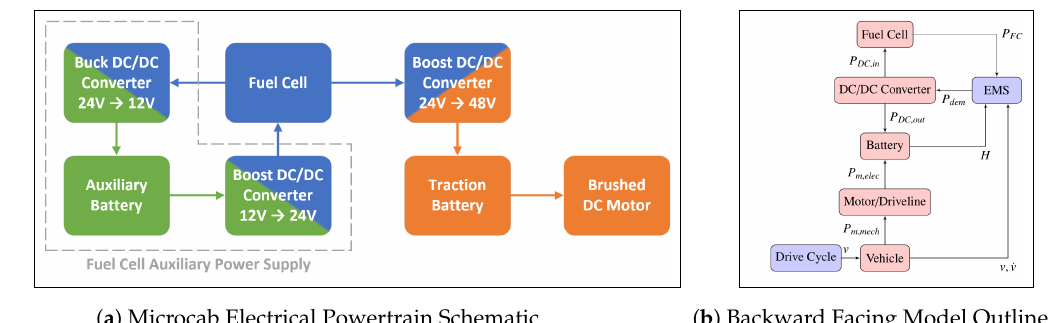
Figure 1. Vehicle